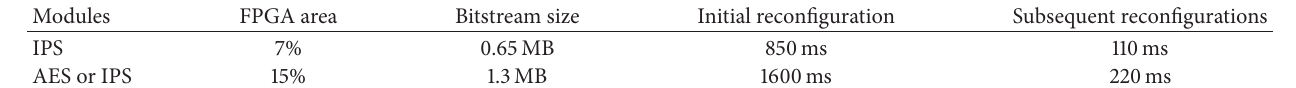
Table 3: Overhead of partial reconfiguration.